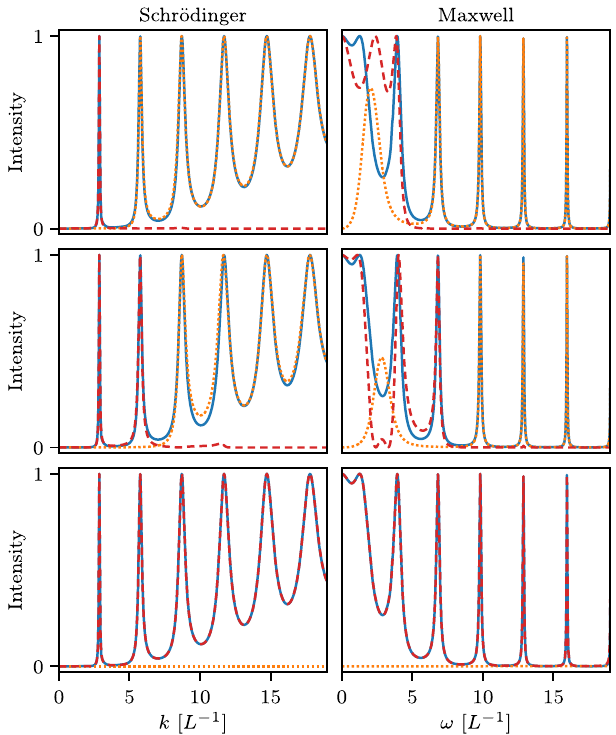
FIG. 7. Transmission spectra for a Schrödinger (left column) and a Maxwell (right column) Fabry-Perot cavity, with different sets of system modes (top, λ ¼ 1 ; middle, λ ∈ f 1 ; 2 g ; bottom, λ ∈ f 1 ; 2 ; … ; 100 g ). In each case, the full (solid blue curve), input-output (dashed red curve), and background (dotted orange curve) transmissivity are shown. For both wave equations, each added system mode transfers a resonance peak from the back- ground to the input-output contribution, such that, in the many- mode case featuring 100 modes, the input-output result alone agrees with the full transmissivity (bottom panels). For sharp resonance peaks, the input-output result captures the behavior in the relevant energy range, if the corresponding modes are included (top and middle left panels). For overlapping resonan- ces, the background contribution is crucial even in the vicinity of the resonance peak (top and middle right